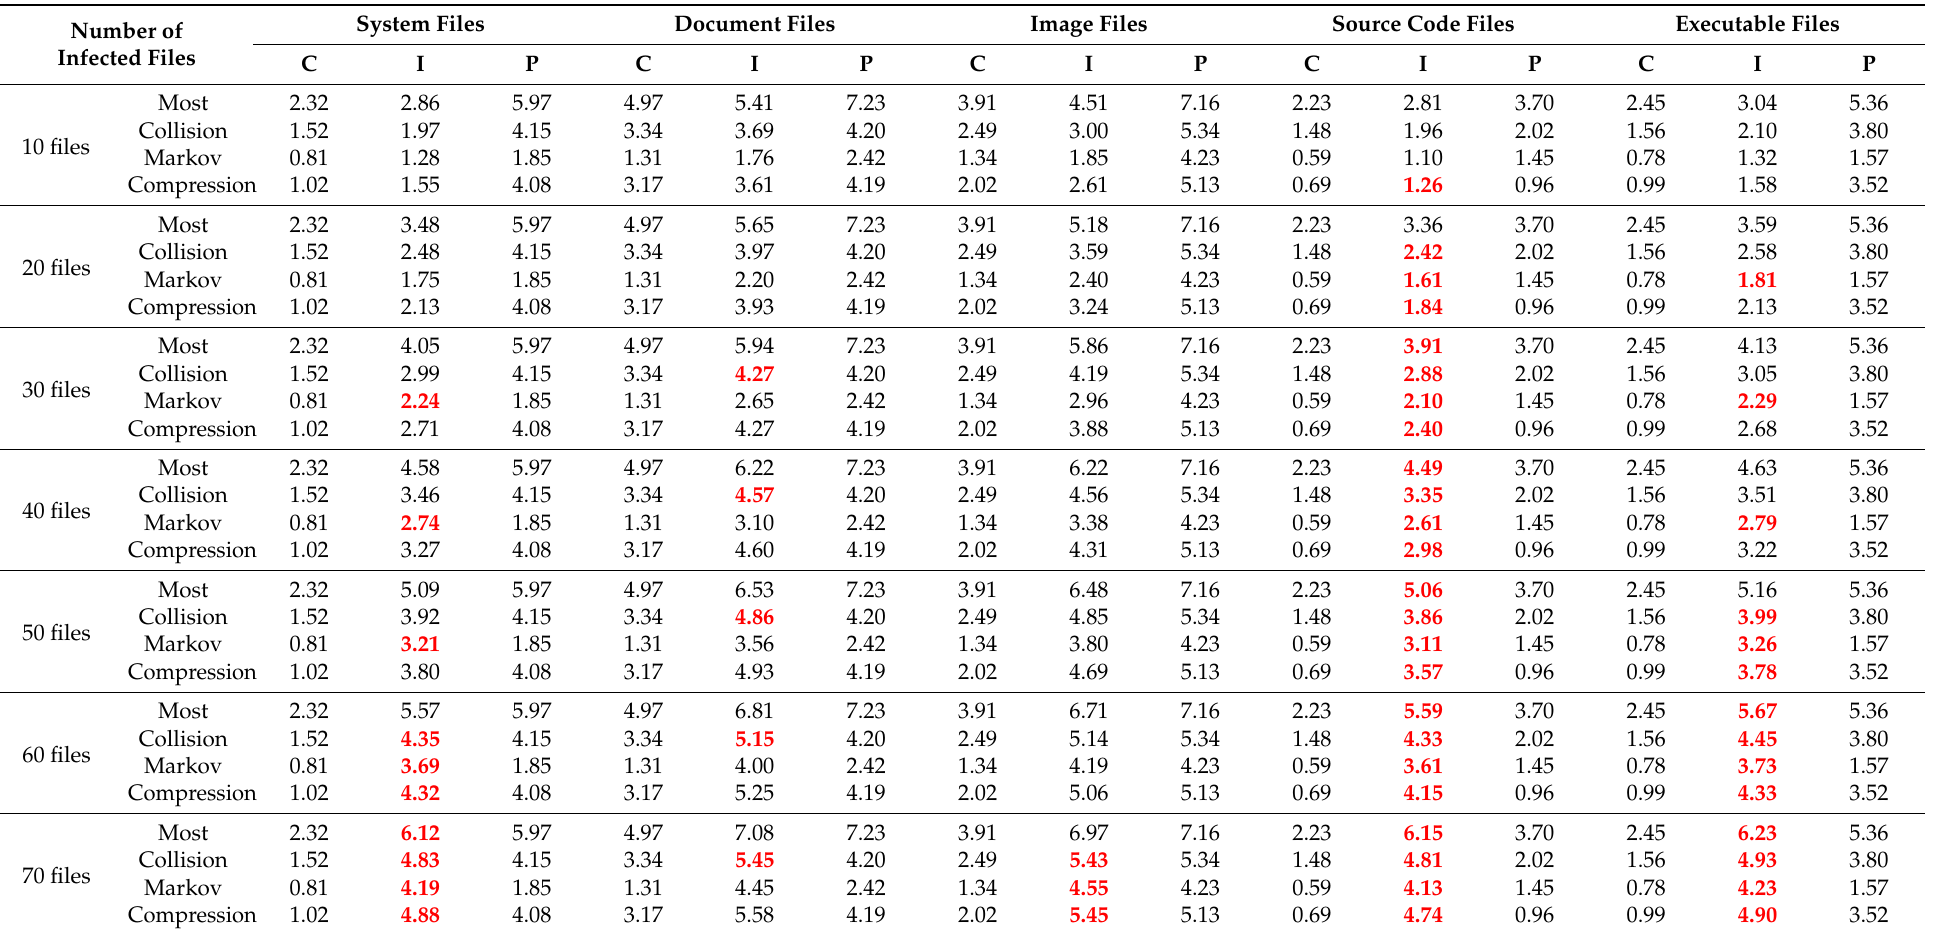
Table 2. Results of the comparison entropy estimate per 10 ransomware-infected files with clean